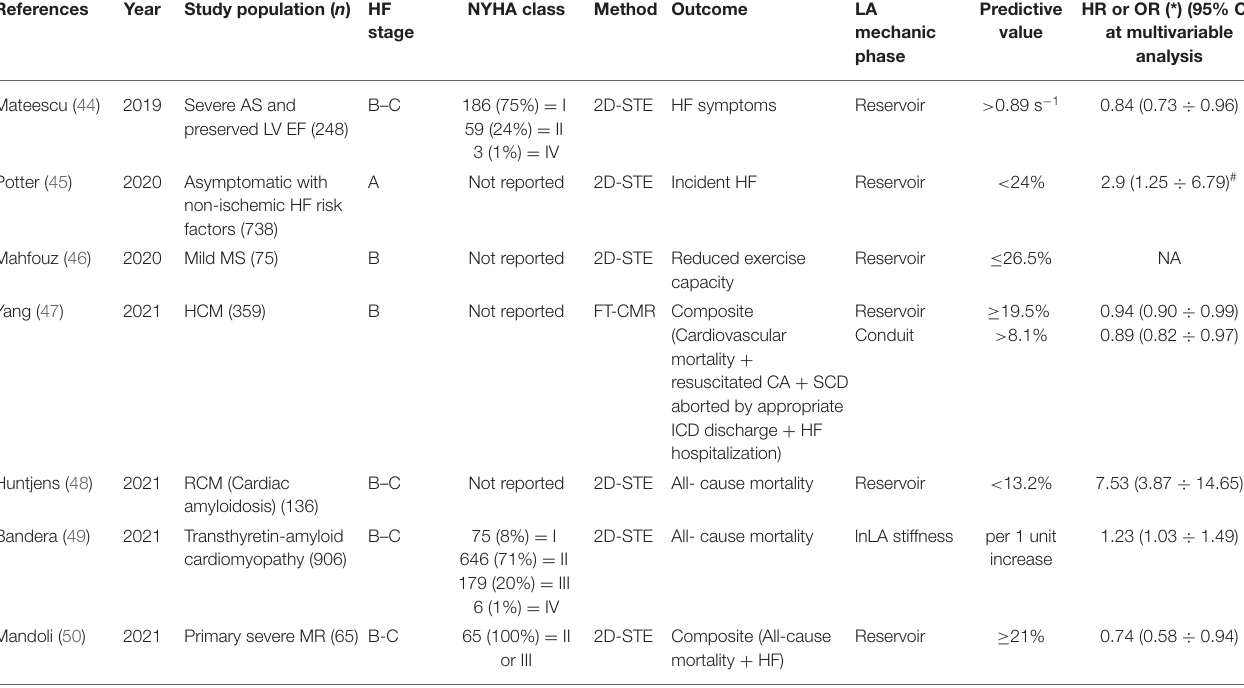
* Odds Ratio; # at univariate analysis; MACE 1: Composite (Cardiac mortality + hospitalization for cardiovascular causes). Tx, transplantation; CA, cardiac arrest; SCD, sudden cardiac death; AHF, Acute heart failure; MV, Mitral Valve; MACE 2, All-cause mortality, cardiac hospitalization, and worsening HF; IHD, ischaemic heart disease; other abbreviations as in the